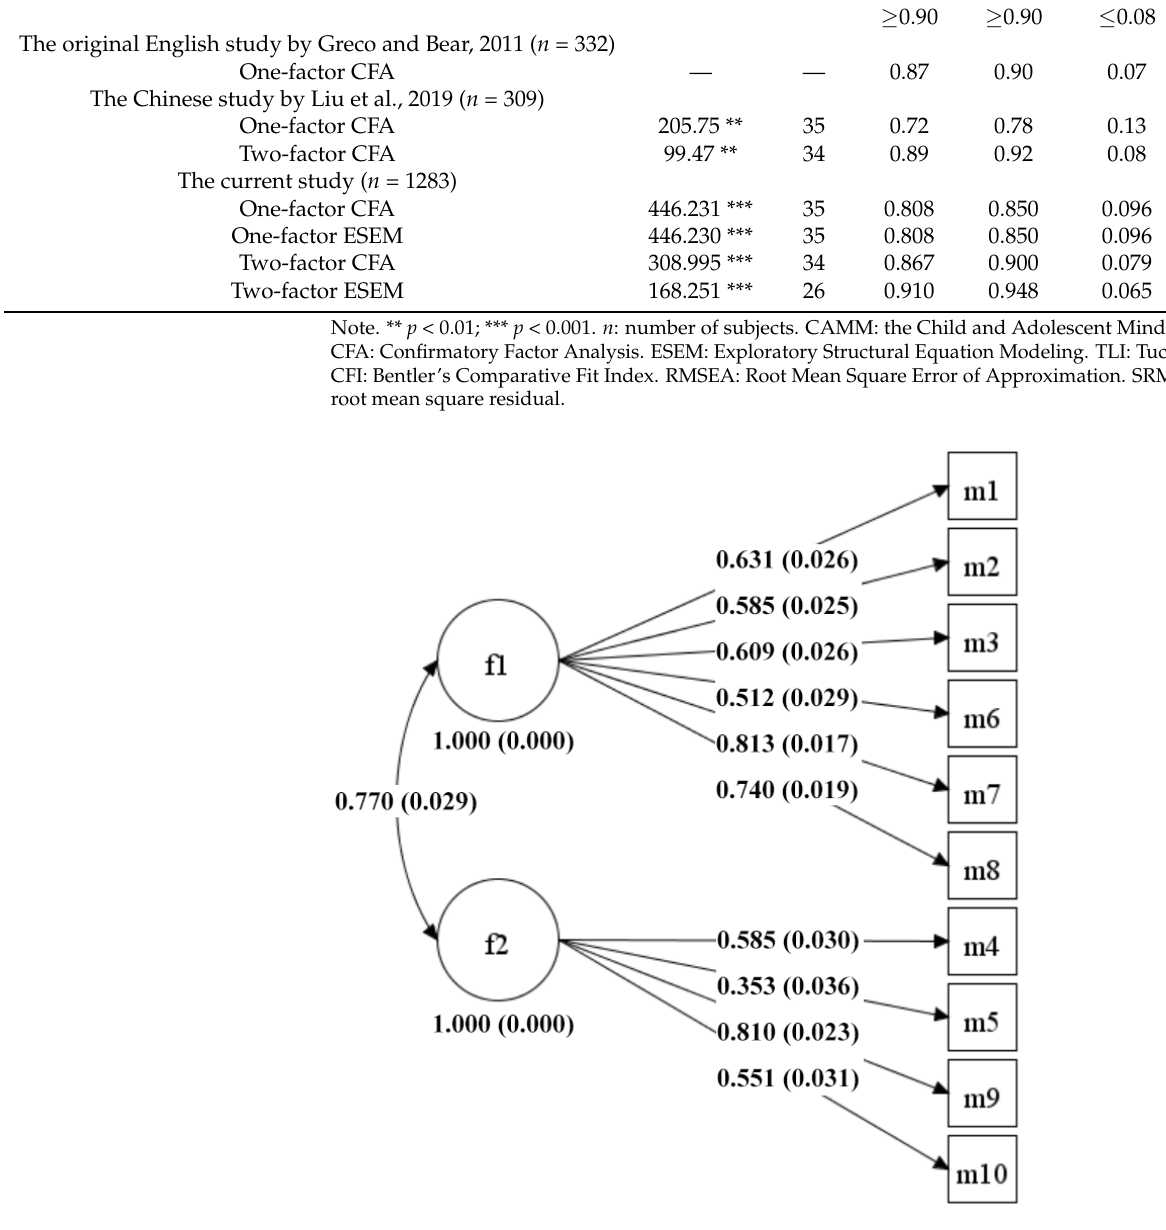
χ 2 df TLI CFI RMSEA SRMR ≥ 0.90 ≥ 0.90 ≤ 0.08 ≤ 0.08